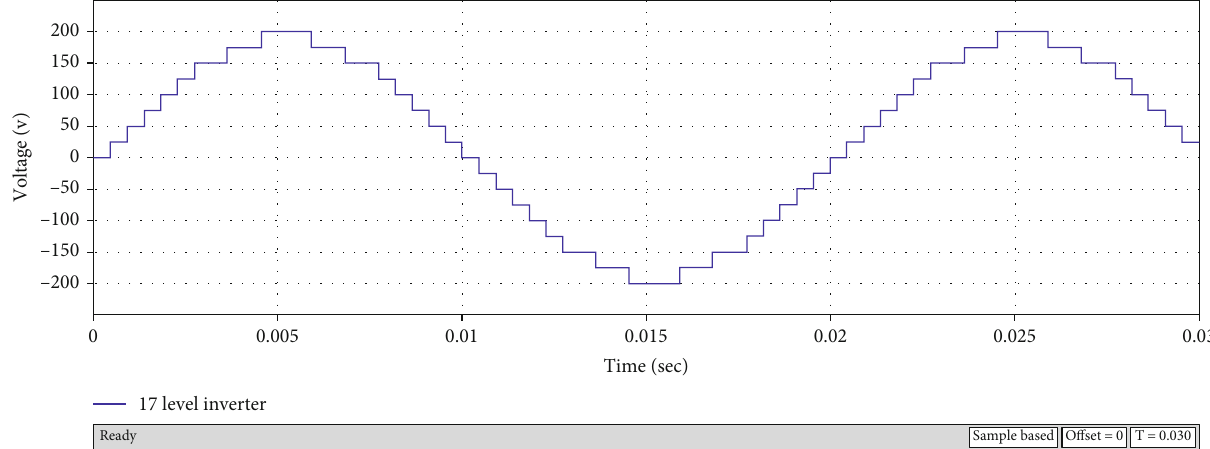
Figure 28: 17-level MLI with t = 0 : 03 for phase